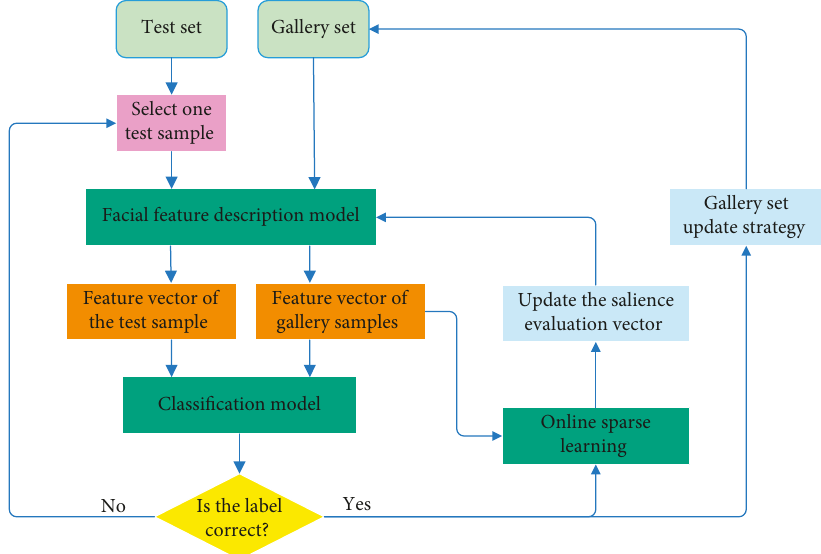
Figure 2: The framework of online sparse learning